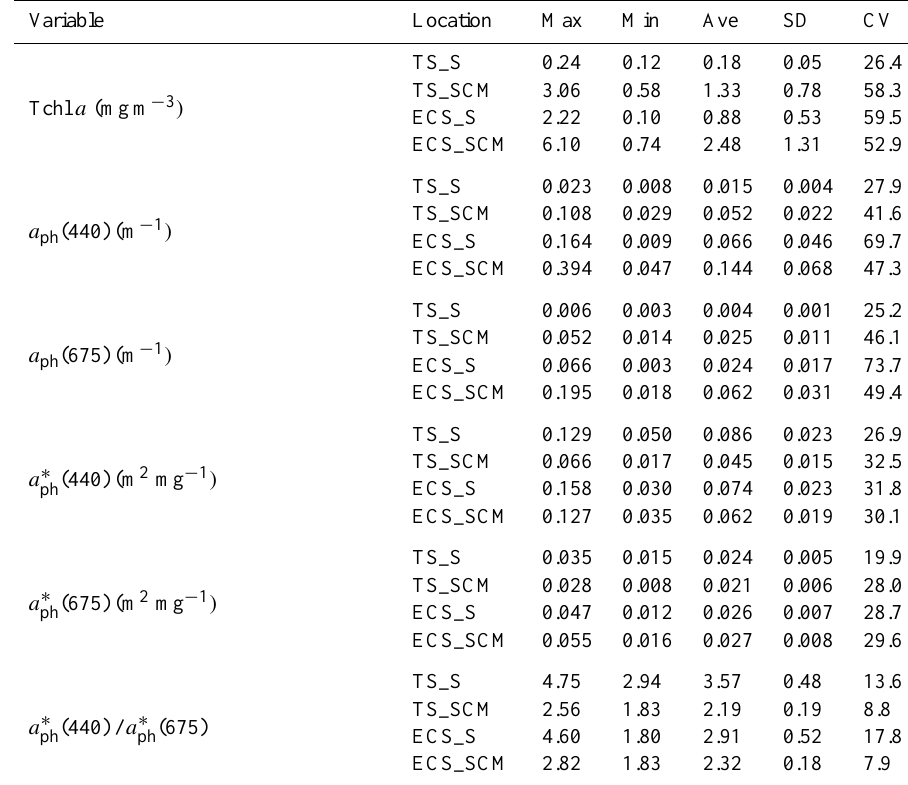
(440) to a ∗ (675) among the Tsushima ph ph